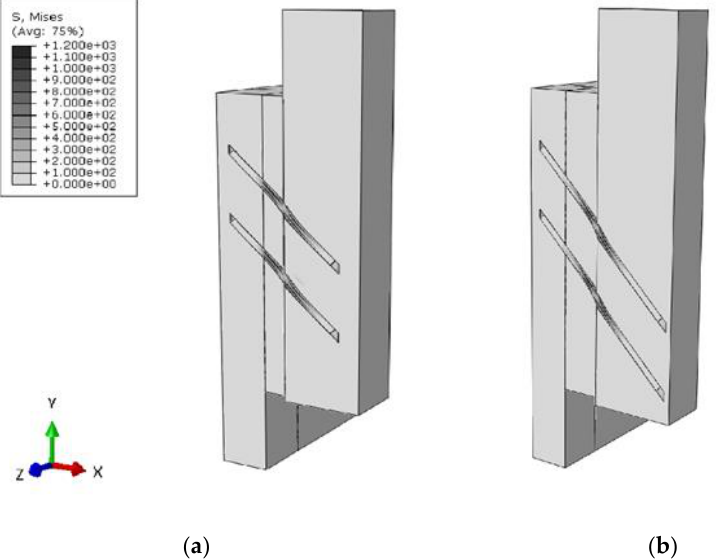
Figure 6. Typical deformed shape and Von Mises stresses for ( a ) E1 (clc8160) and ( b ) E2 (clc8240) models.